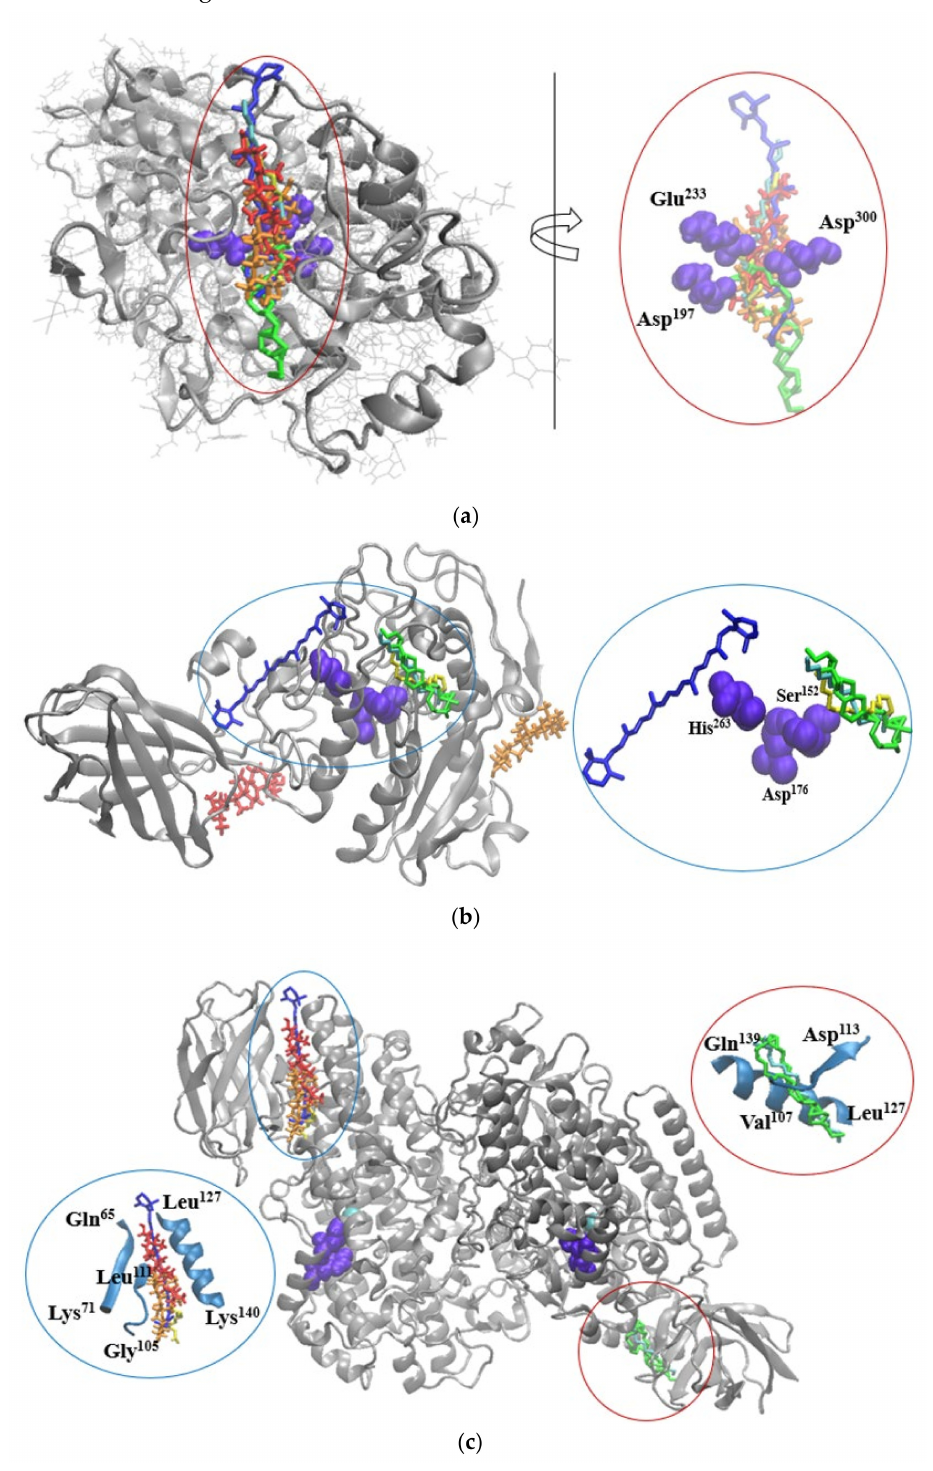
Figure 2. Superposition of the molecular docking results showing the complexes formed by α -amylase ( a ), lipase ( b ), and lipoxygenase ( c ), represented New Cartoon style in silver, with BCR (blue), BST (red), BTF (orange), LA (green), OA (cyan), and/or PA (yellow) represented in Licorice style. The catalytic amino acids establishing contacts with the ligands are represented in violet in Van der Waals style. In the insets details are given on the binding of the ligands to the catalytic amino acids of α -amylase ( a ), and lipase ( b ), or to the binding patches on lipoxygenase surface ( c ). Images were prepared using VMD software